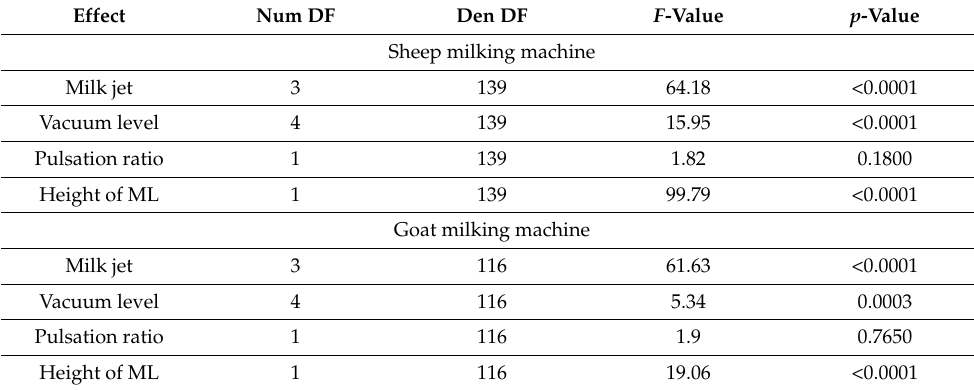
Table 1. The individual effects with the associated degrees of freedom (Num DF/Den DF, the F -values and the p -values).